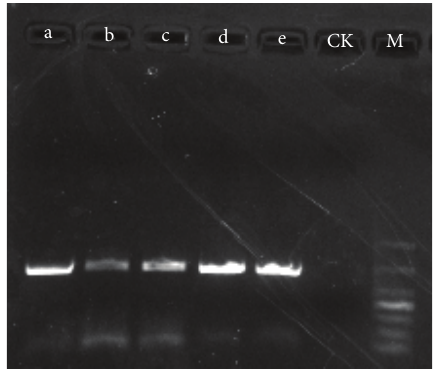
Figure 5: Reverse transcriptase PCR amplification of the partial hsp gene. Lane a–e: inoculated reactors with 250, 500, 800, 1000, and 1200 mg/L nicotine on the 20th day, respectively; Lane CK: original activated sludge at 0 day; Lane M: DL 1000